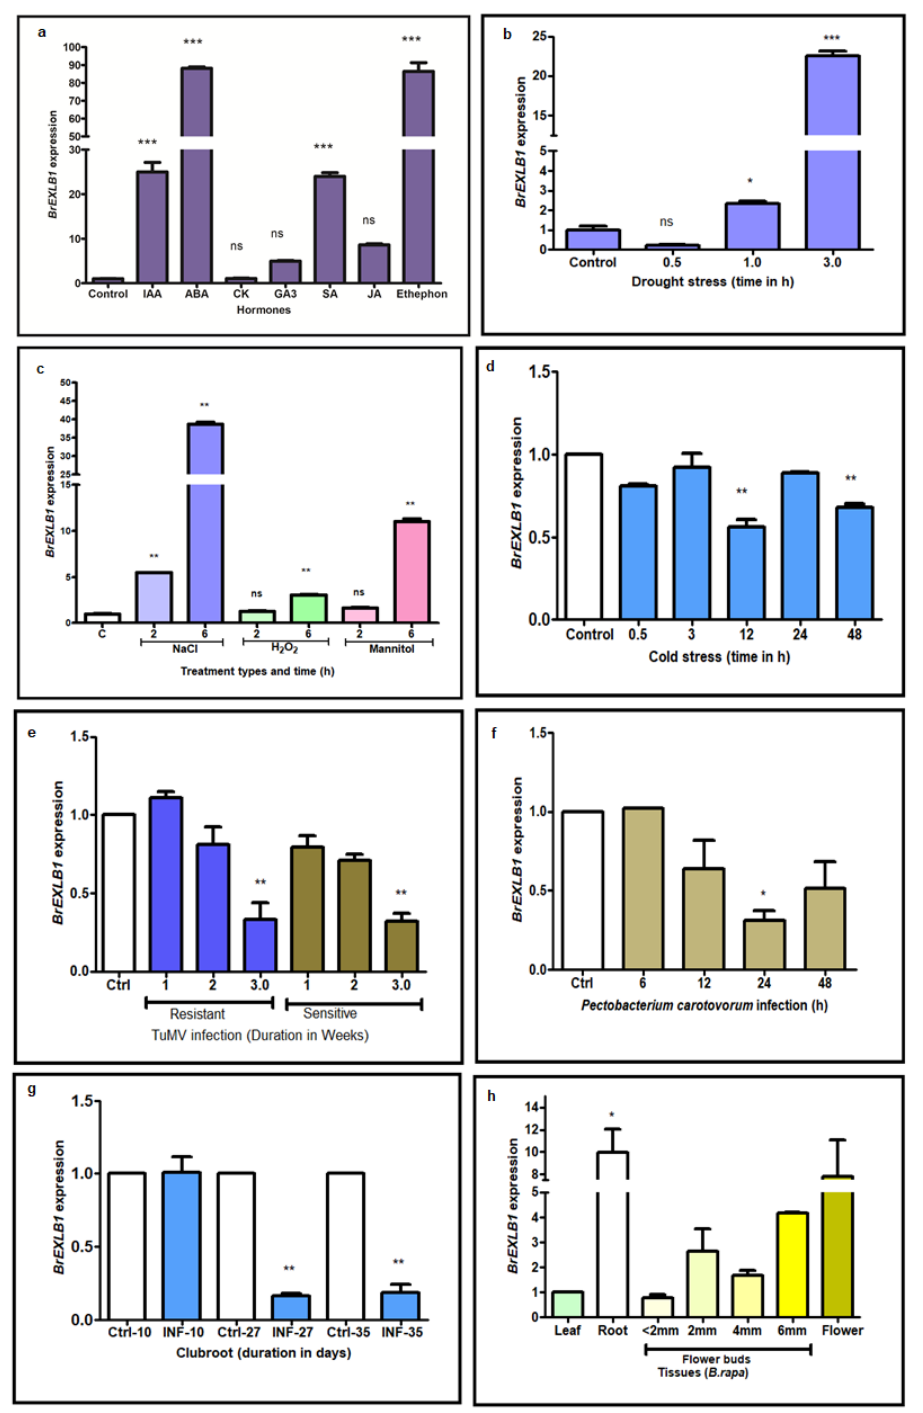
Figure 1. Differential expression pattern of BrEXLB1 in response to different hormones, abiotic, and biotic stress conditions. The graphs depict the relative quantification of transcripts of BrEXLB1 during the exogenous application of hormones ( a ) such as indole-3-acetic acid (IAA), abscisic acid (ABA), cytokinin (CK), gibberellin (GA3), salicylic acid (SA), jasmonic acid (JA), ethylene (Ethophen), drought stress ( b ); salt stress (NaCl), oxidative stress (H 2 O 2 ), and osmotic stress (D-Mannitol) ( c ); cold stress ( d ); Turnip mosaic Virus infection (TuMV) ( e ); Pectobacterium carotovorum infection ( f ); clubroot disease ( g ); and tissue-specific expression in Brassica rapa ( h ) plants (** represents statistical significance). INF denotes infection; C or Control or Ctrl denotes wild type